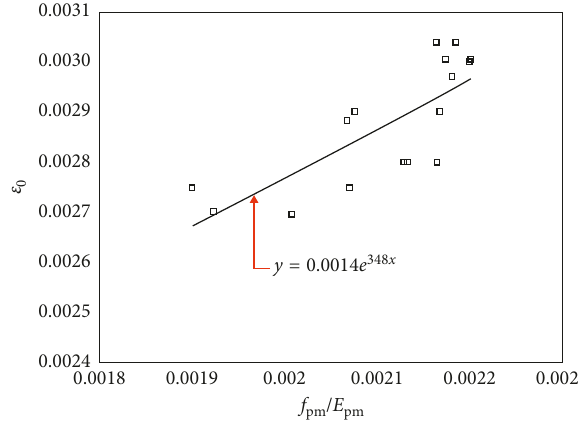
Figure 9: Regression analysis for ε